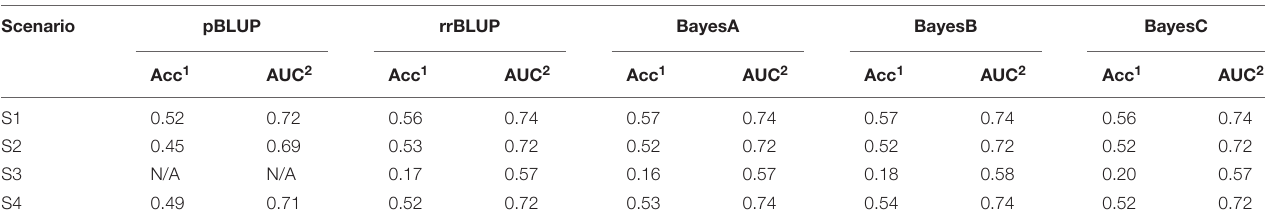
TABLE 2 | Prediction metrics for varying genetic relationships in the validation